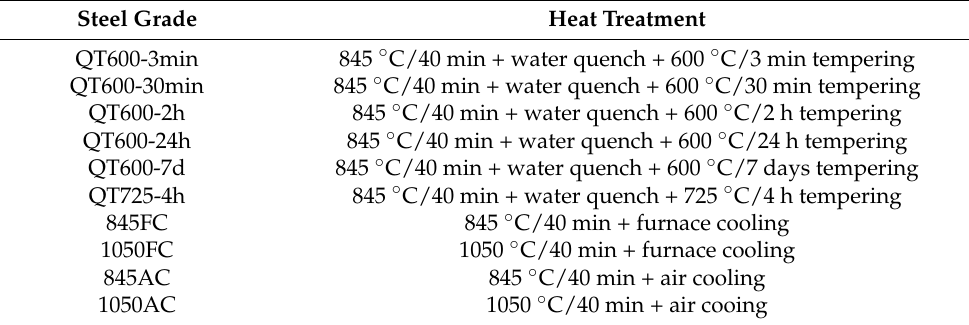
Table 2. Heat treatments applied to 42CrMo4 steel and obtained